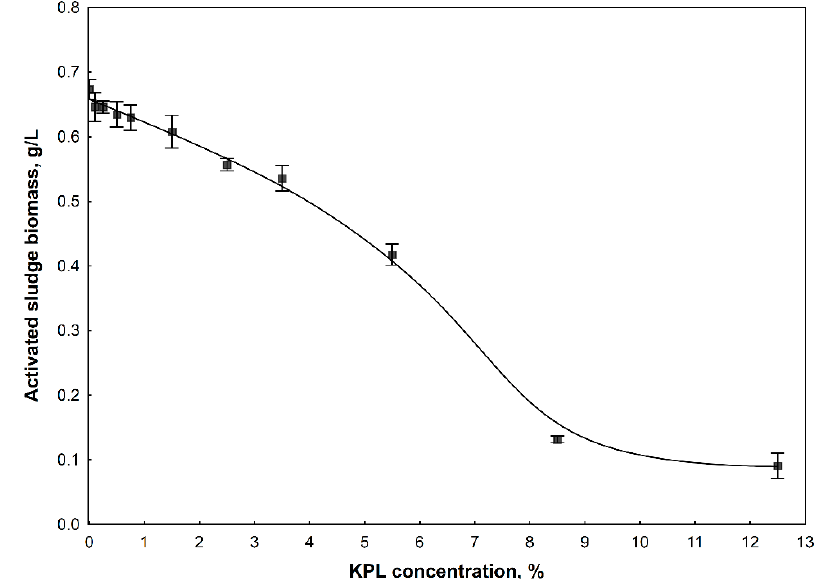
Figure 2. The growth inhibition of the activated sludge microorganisms in the presence of various concentration of the KPL. Estimated values of ecotoxicity of the leachate: NIC = 3.45 ± 0.01, EC 50 = 6.69 ± 0.70, and MIC = 11.26 ± 0.35.